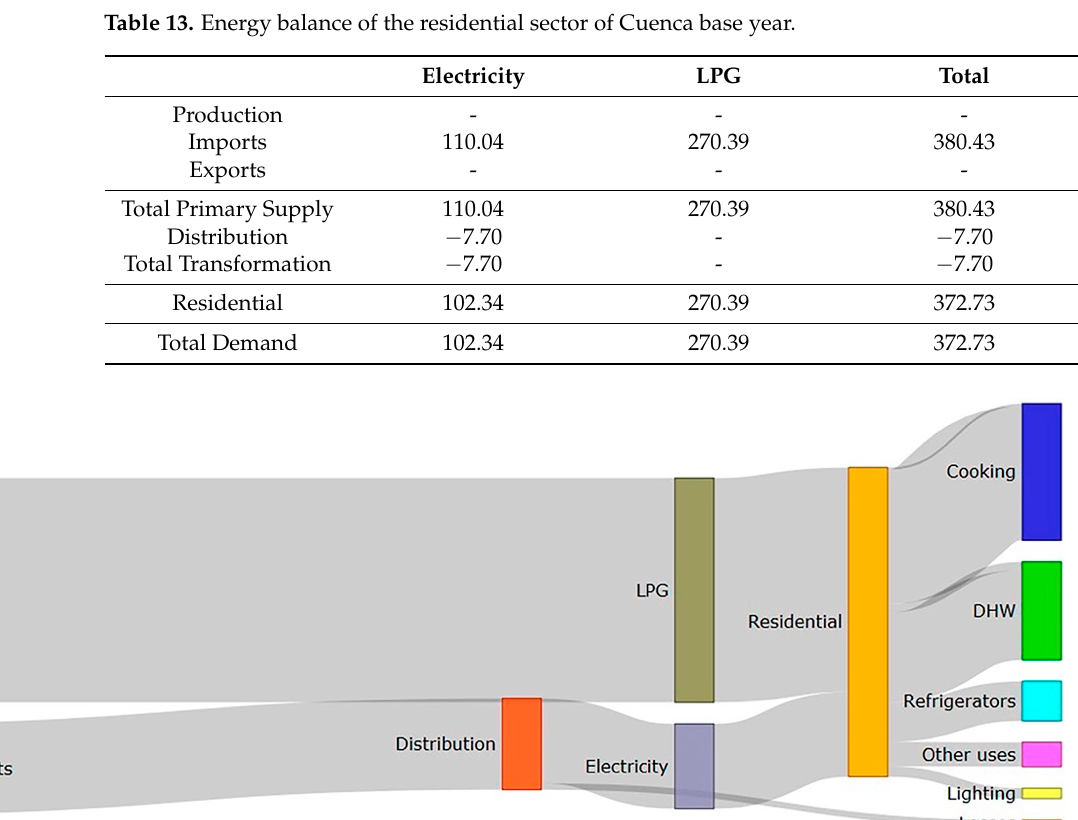
Table 12. Energy balance of the city of Cuenca canton (kBOE)